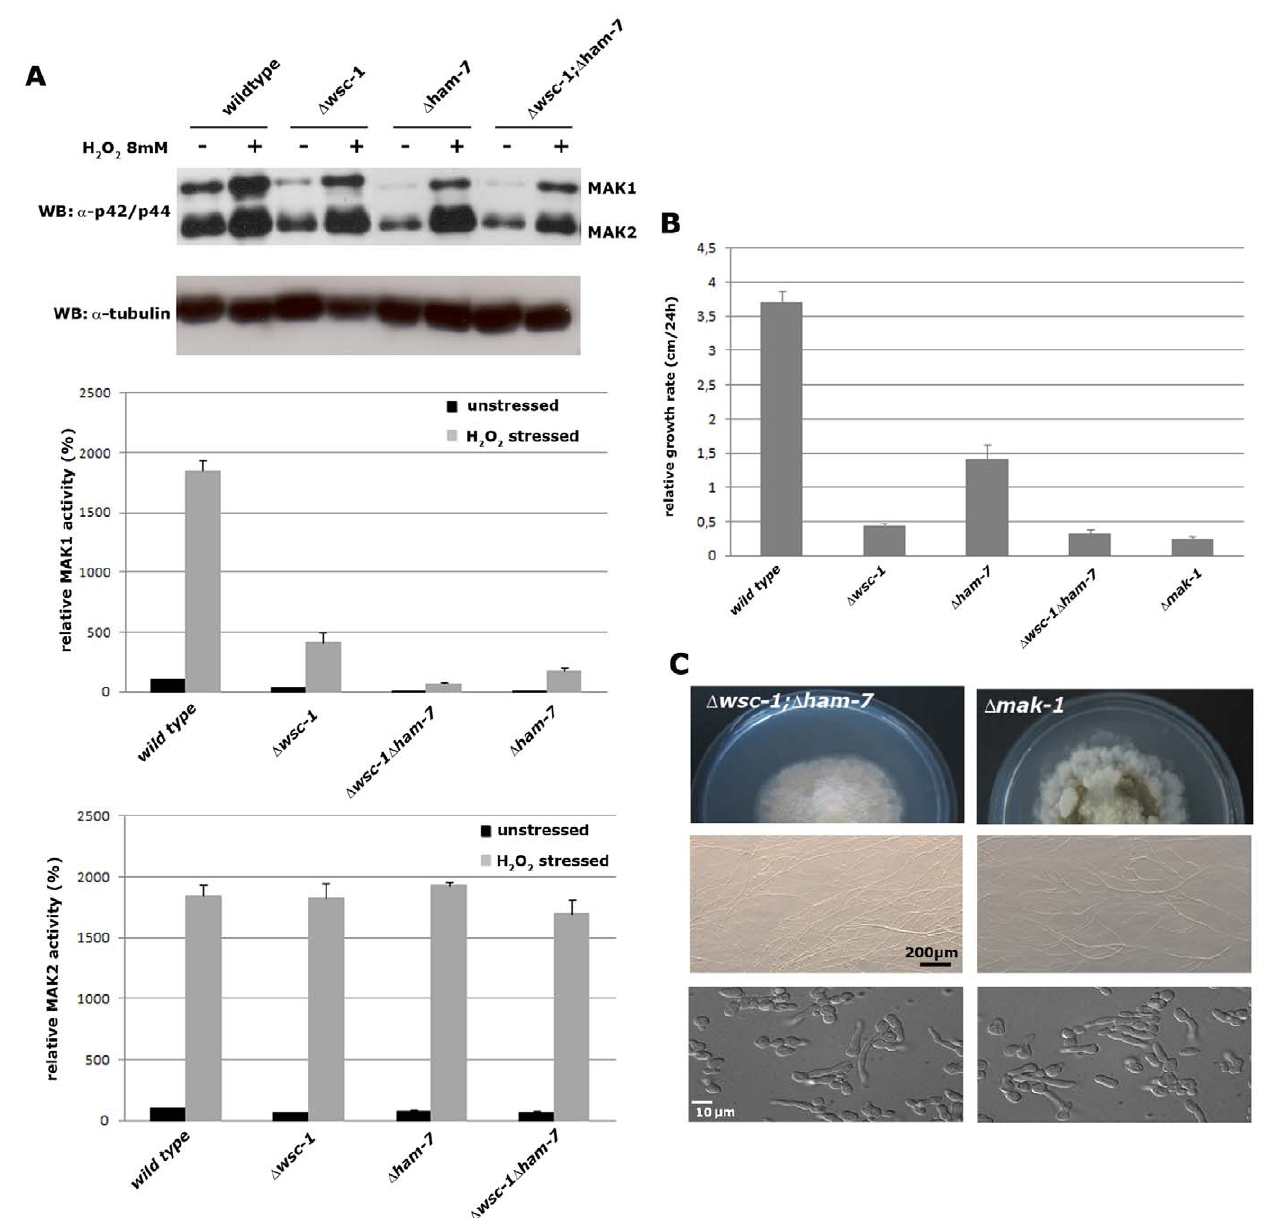
Figure 5. D wsc-1 , D ham-7 , and D wsc-1; D ham-7 are deficient in MAK-1 activation. ( A ) In the upper panel, extracts of non-stressed and oxidatively stressed wild type, D wsc-1 , D ham-7 , and D wsc-1; D ham-7 cells were prepared and assayed for the presence of phosphorylated MAK-1 and MAK-2 by a Western blot assay using antibody that specifically recognizes the phosphorylated proteins. Extracts from non-stressed and from stressed cells are denoted by – and + . The sizes of the MAK-1 and MAK-2 proteins are shown at the side of the Western blot. A Western blot against tubulin was used as a control and to calibrate the amounts of protein in each of the samples. The amounts of activated MAK-1 (middle panel) and MAK-2 (lower panel) in each of the samples relative to the amount of activated MAK-1 or MAK-2 in the non-stressed wild type cell are shown (n=5). ( B ) The colony extension rates for wild type, D wsc-1 , D ham-7 , D wsc-1; D ham-7 , and D mak-1 are shown. ( C ) The colony morphology (upper panel), the lack of protoperithecia production (middle panel), and lack of CAT fusion (lower panel) are shown for D wsc-1; D ham-7 , and D mak-1